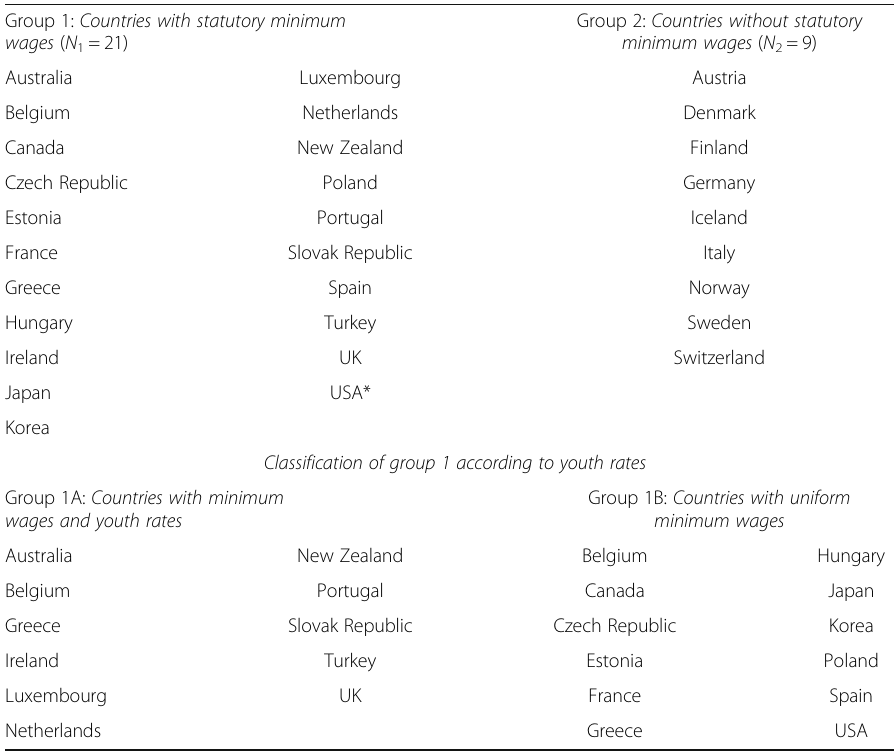
Table 1 Classification of countries on minimum wage systems (2000 – 2014) Group 1: Countries with statutory minimum wages ( Ν 1 = 21)